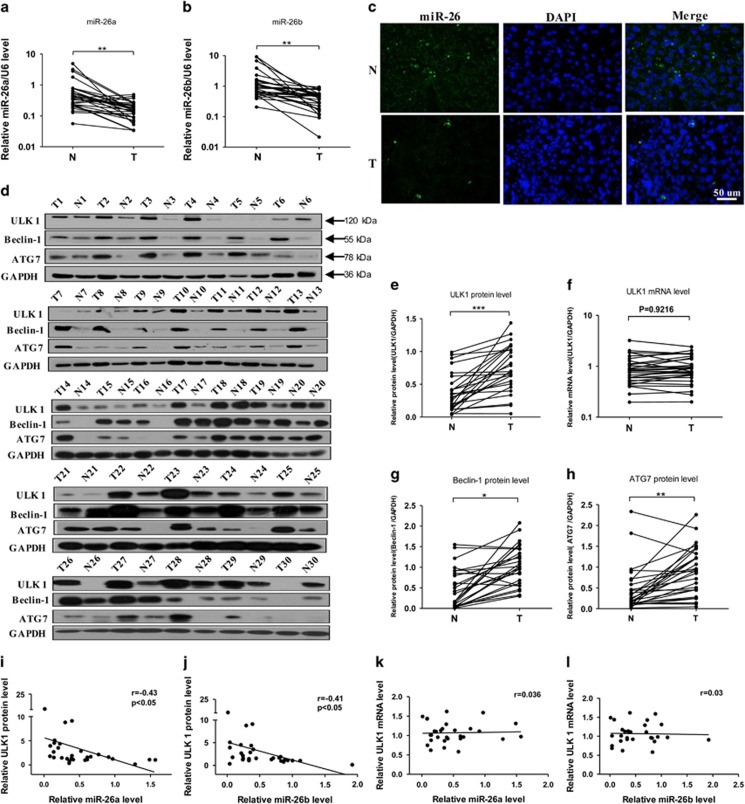
MiR-26a/b is inversely correlated with increased autophagy in tumor tissues of patients with HCC. (a–c) Relative levels of miR-26a/b (expressed as the miRNA/U6 ratio) in tumor tissues (T) and the corresponding background livers (N) were determined using RT-qPCR and in situ hybridization assays. Data are shown as the means±S.E.M.; n=30 in each group. (d) Protein levels of ULK1, Beclin-1 and ATG7 were determined using western blotting in 30 pairs of samples. GAPDH was used as an internal control. (e–h) Quantitative analyses of the protein and mRNA levels of ULK1, Beclin-1 and ATG7 in 30 pairs of HCC samples. (i–l) Pearson's correlation scatter plot of the fold changes of miR-26a/b and ULK1 protein, mRNA in HCC tissues. *P<0.05; **P<0.01; and ***P<0.001